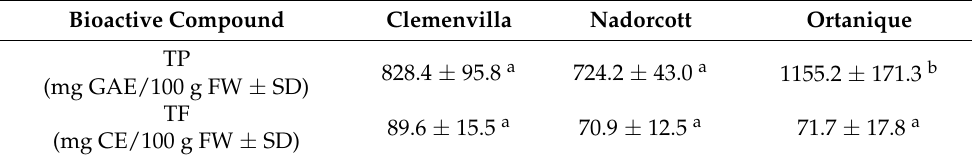
Table 1. Total polyphenol and flavonoid contents determined in hybrid mandarin peels.